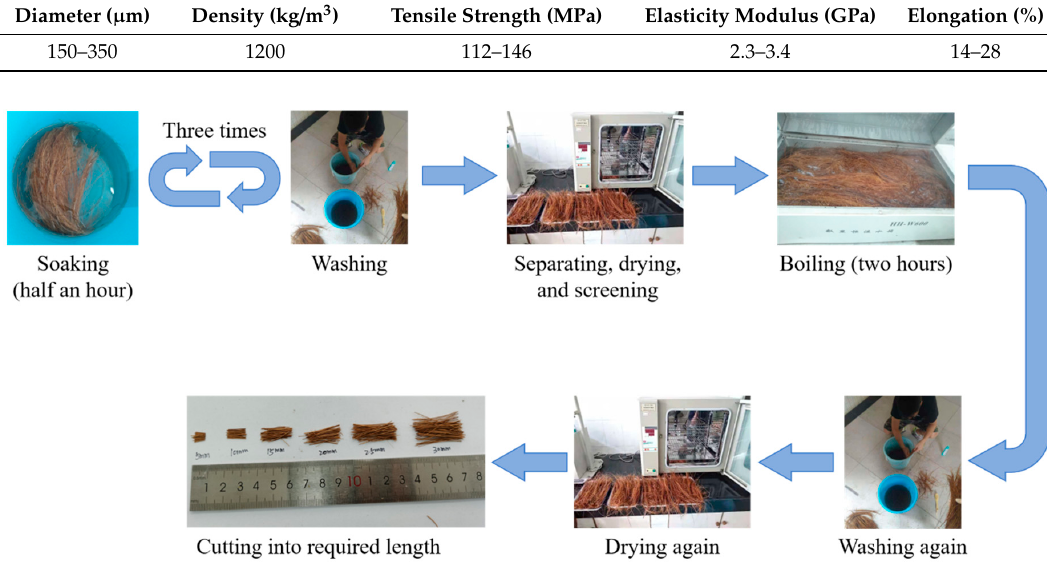
Table 5. Physical properties of coir fiber (CF).